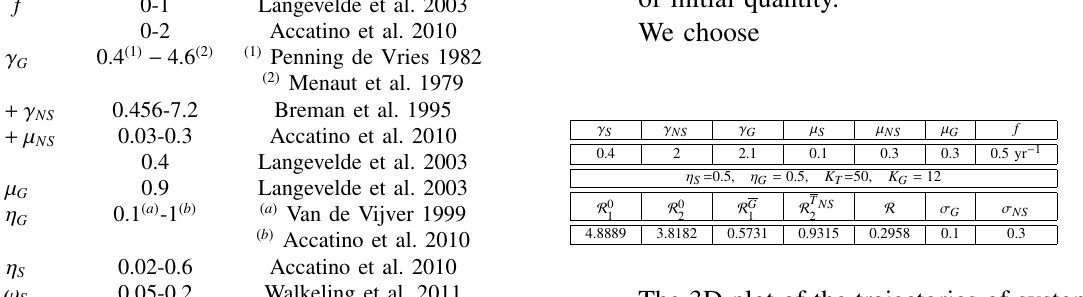
The 3D plot of the trajectories of system (1) is depicted in Figure 2. It clearly ap- pears that the forest and grassland equi- libria are stables. Figure 2 illustrates the bistability situation presented in Ligne 7 of Table I.